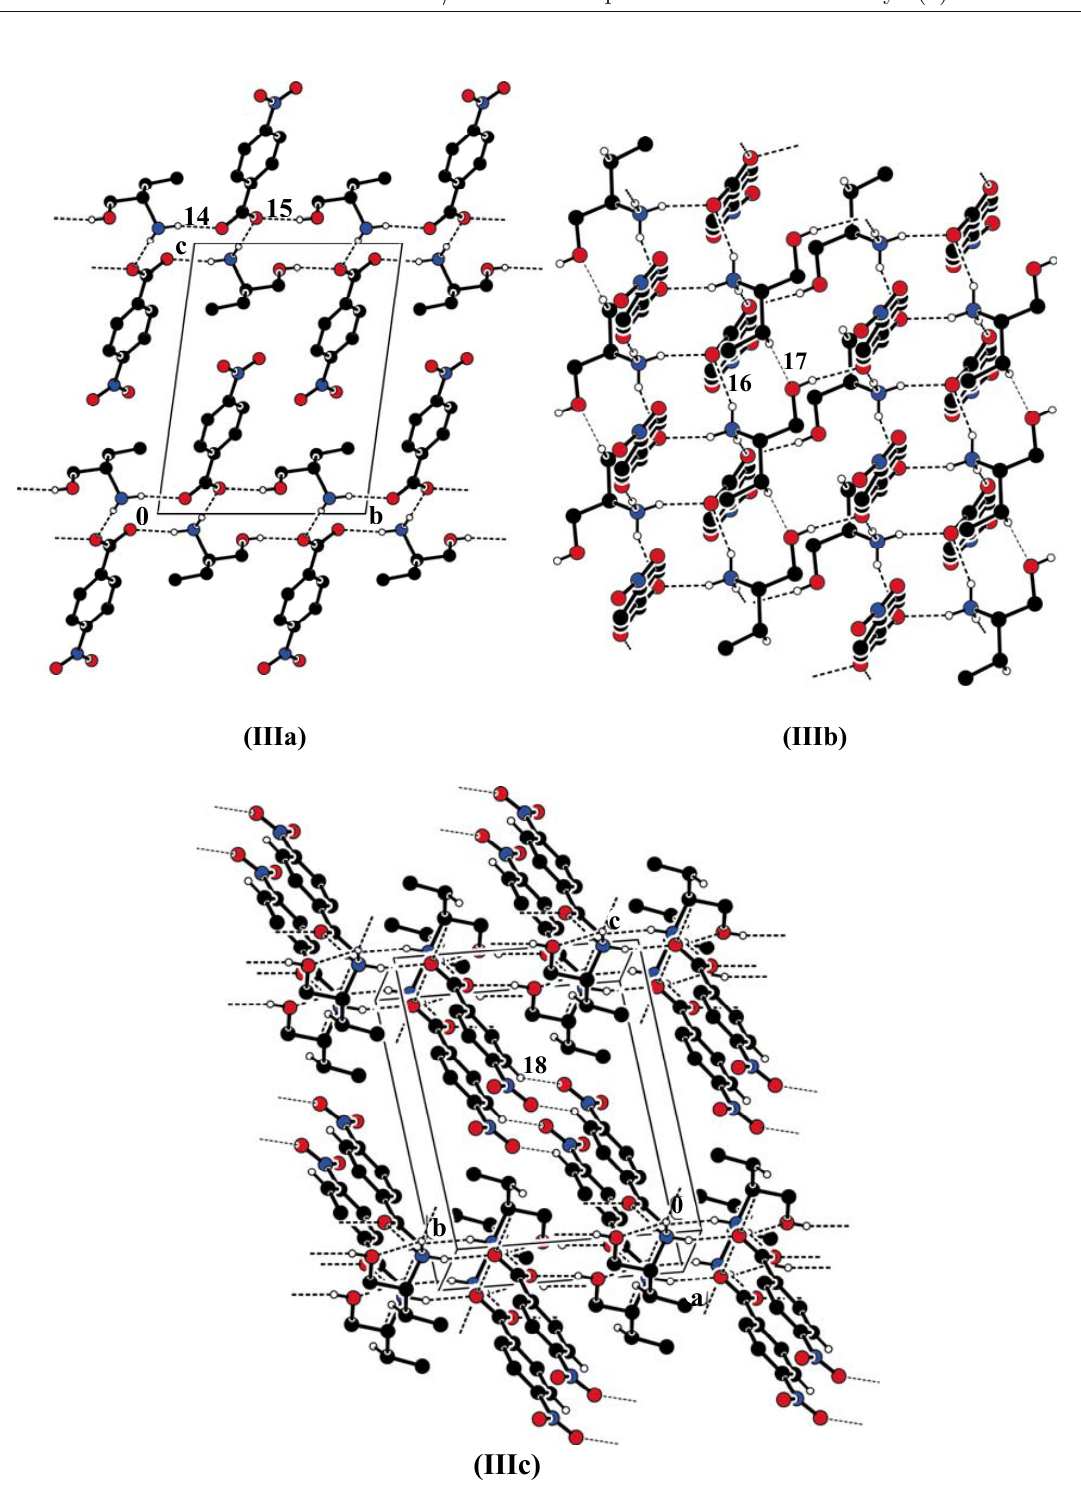
Fig. 4 ( IIIa ) The chains along b direction in III formed by N2 ... O2 (14) and O5 ... O1 (15) hydrogen bonds (dashed